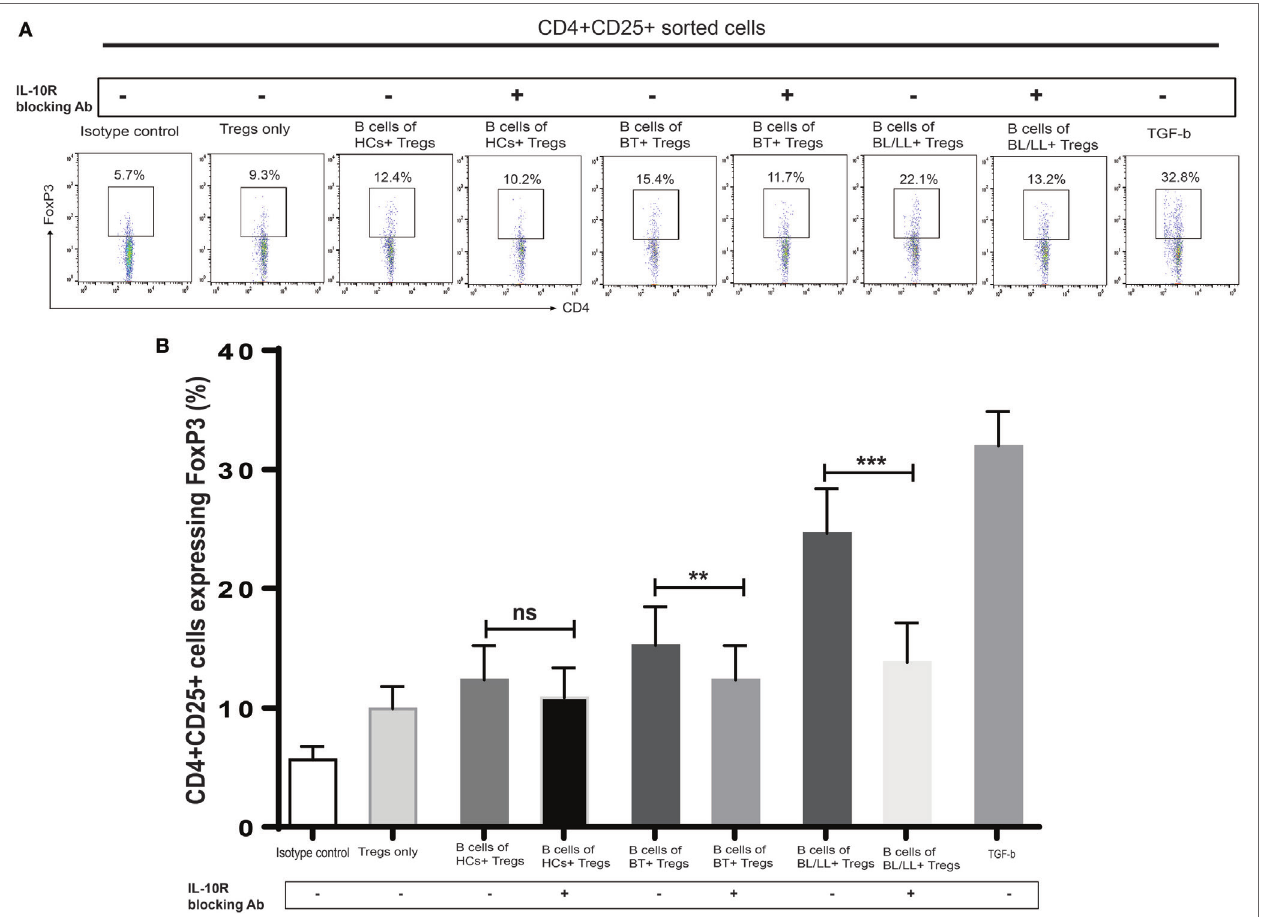
FigUre 6 | Effect of interleukin-10 (IL-10) blocking signaling of regulatory B cells (Bregs) on Tregs. (a,B) . Representative flow cytometric analysis and graph plot of FoxP3 expression in Tregs (CD4 + CD25 + ). Bregs isolated from HCs, BT, and BL/LL ( n = 6) blocked with antibody against IL-10 and cocultured with Tregs (CD4 + CD25 + ) and expression of FoxP3 in CD4 + CD25 + was analyzed by flowcytometry after 48 h of culture. Isotype controls and TGF- β (20 ng/ml) were taken as negative and positive controls in both experiments. Mean ± SD values are shown in each set while p value < 0.05 was considered significant. 50,000 cells were acquired and analyzed by flow cytometry. Data analysis was performed with flowjo software. Statistical analysis was done using Student’s t -test for unpaired samples (* p < 0.05; ** p < 0.005; *** p <